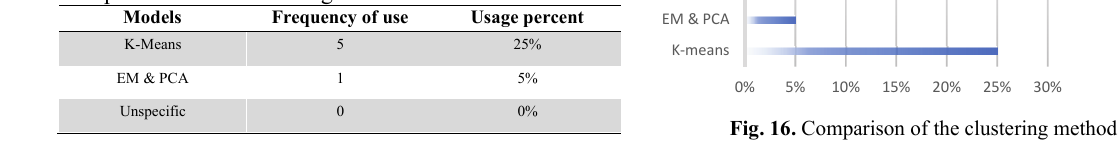
Comparison of the clustering methods